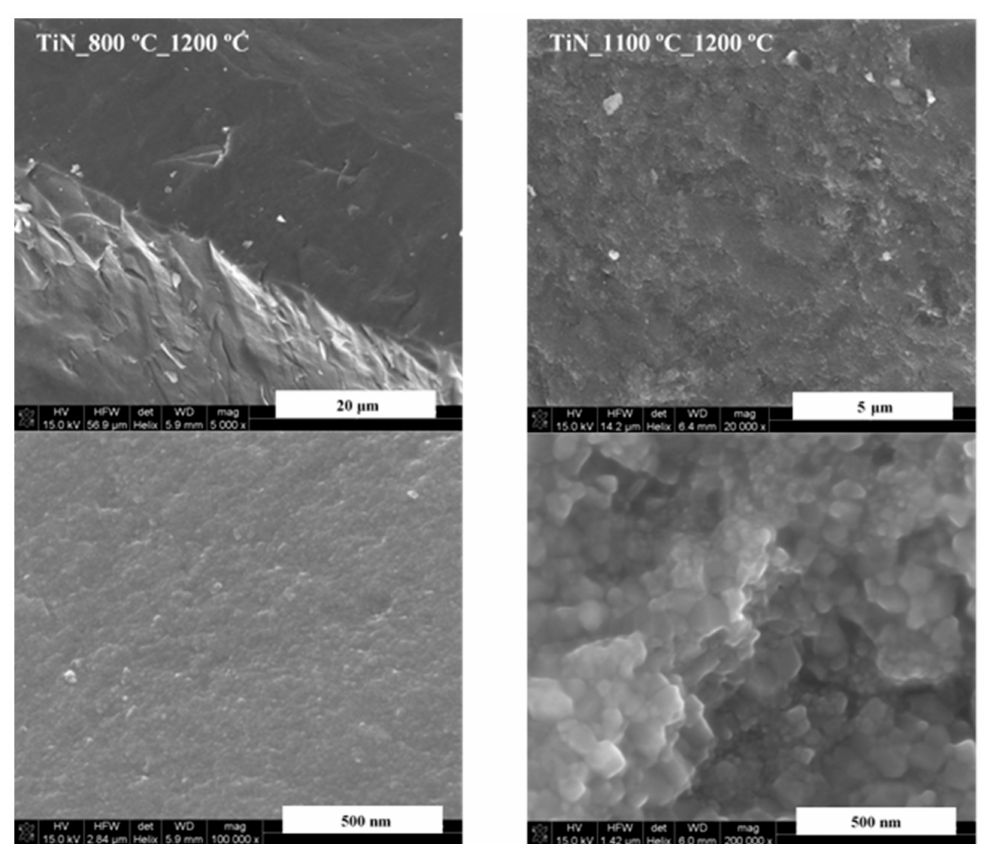
Figure 7. SEM images of pure TiN nanoceramics: ( left )—powder made at 800 ◦ C and sintered at 1200 ◦ C. Note the solid appearance of fractured area in the left top image; ( right )—powder made at 1100 ◦ C and sintered at 1200 ◦ C. Note the polished pellet’s surface in the right top